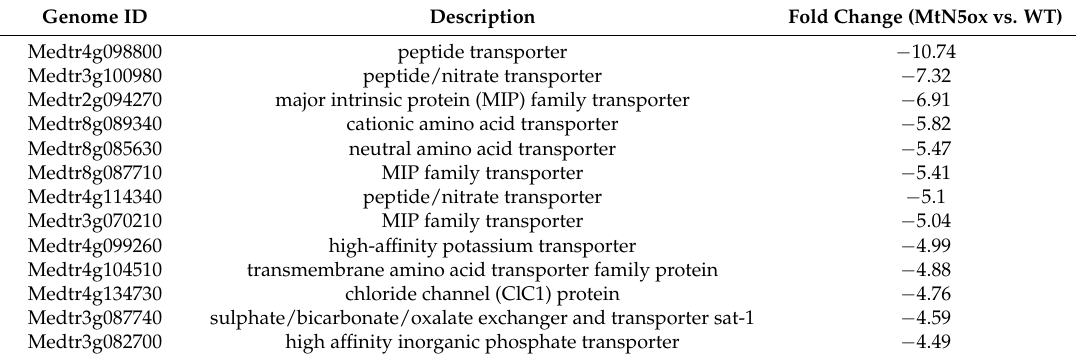
Table 1. Differentially expressed transcripts involved in transport metabolism discussed in the